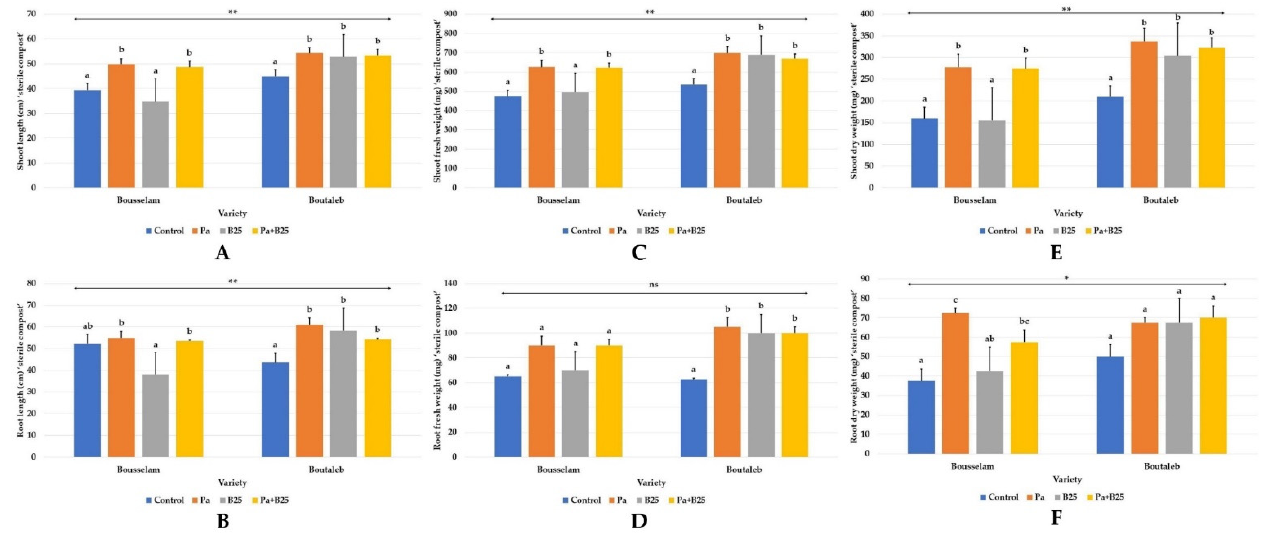
Figure 3. Effect of bacterial inoculation on ( A , B ) shoot and root length (cm), ( C , D ) shoot and root fresh weight (g), and ( E , F ) shoot and root dry weight of wheat plants grown in sterile compost of Bousselam and Boutaleb varieties. The bar plots represent the mean ± standard error of three different experiments. IBM SPSS Statistics v.24 was used to perform statistical analysis, using a two-way ANOVA and Tukey’s multiple comparison post-test. Significant differences are displayed as: * p < 0.05, ** p < 0.01. ns: non-significant.